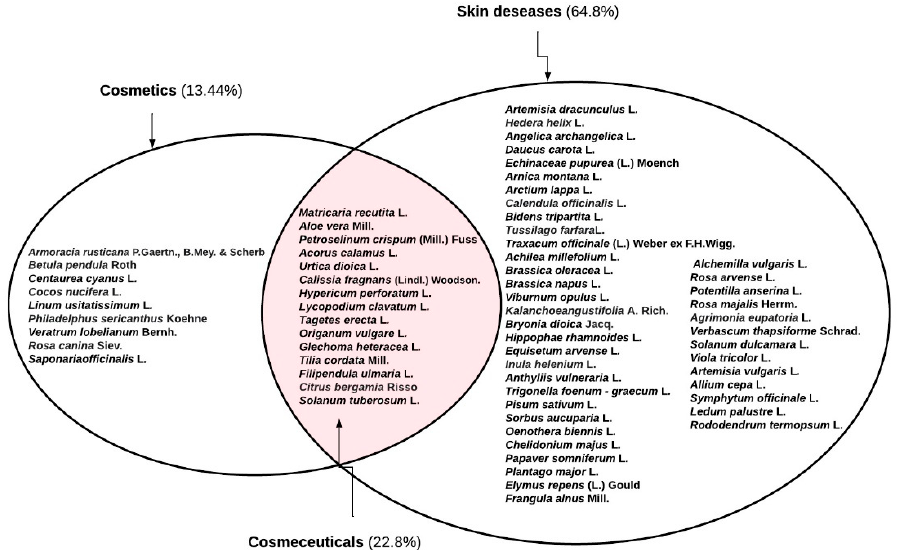
Figure 7. Use categories of medicinal